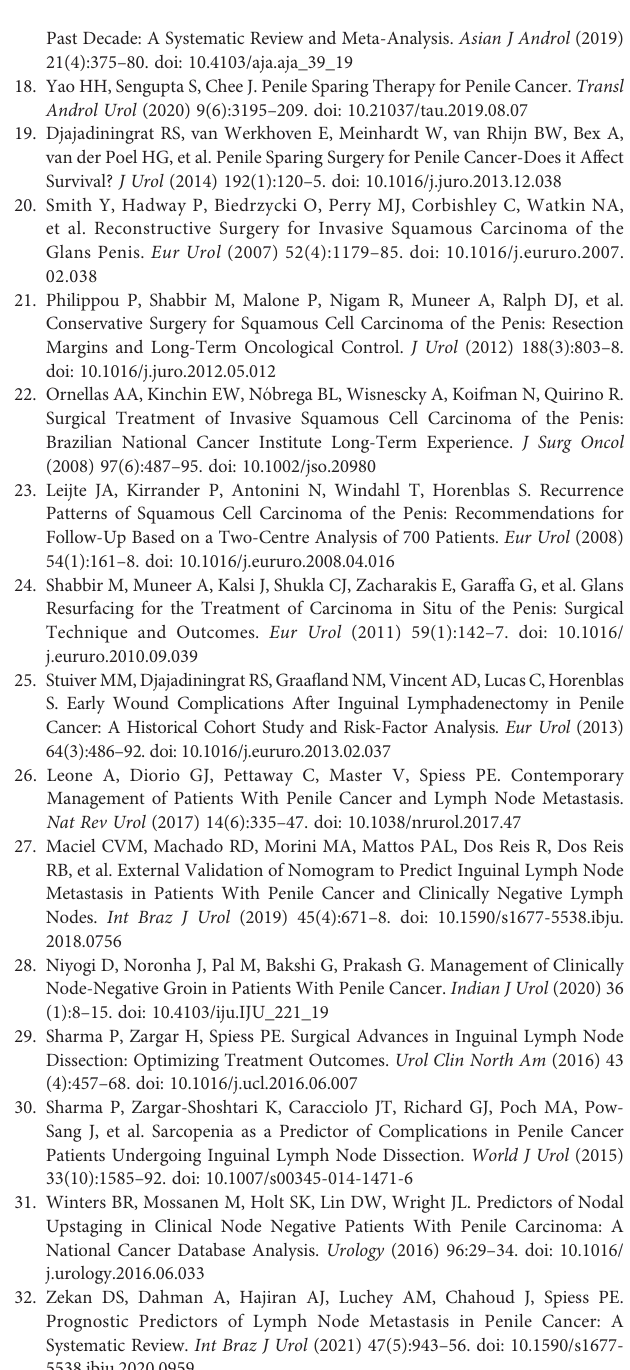
Supplementary Figure 1 | Schoenfeld residual test for variables included in the over-all survival Cox regression. Supplementary Figure 2 | Schoenfeld residual test for variables included in the cancer-speci fi c survival Cox regression. Supplementary Figure3 | P valuedistributions ofKManalysis forover-all survival (A) and cancer-speci fi c survival (B) in 100 PSM